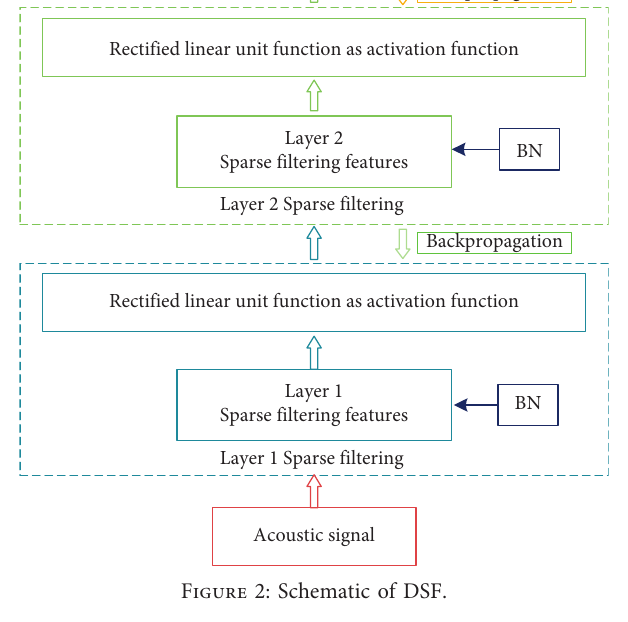
Figure 2: Schematic of DSF.